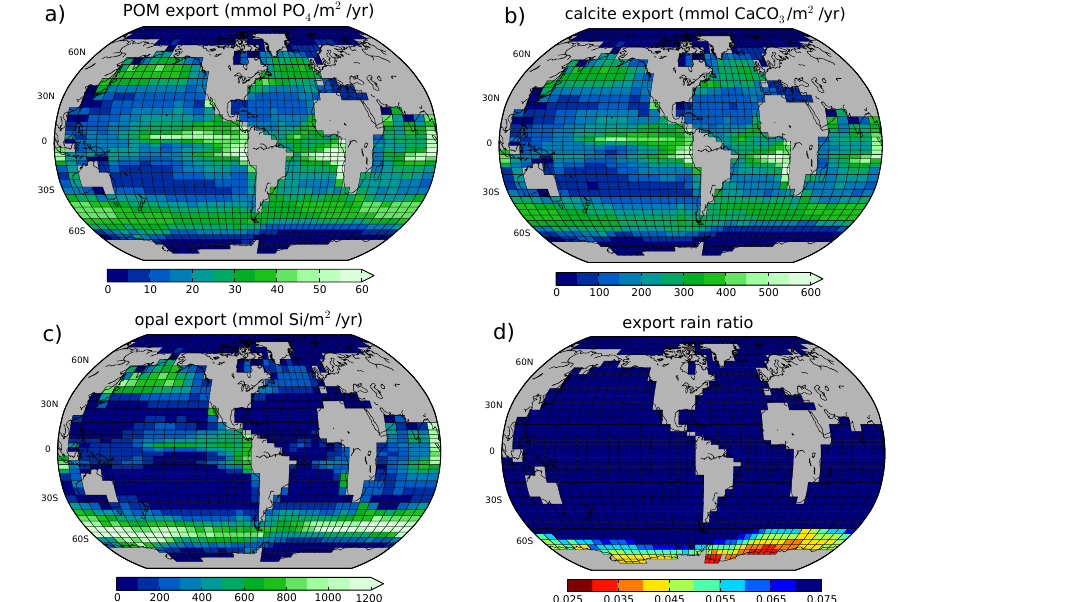
Figure 1. Preindustrial, annual mean distribution of (a) POM export, (b) calcite export, (c) opal export. The ratio of inorganic to organic carbon export (rain ratio) is shown in (d)